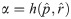
ppGpp regulation implements an on-off control strategy of resource allocation.A: Response surface of the on-off control strategy, defined by α=h(p^,r^) in Eq 19. B: Response surface of the ppGpp control strategy, as defined by Eq 20 and the simplified kinetic model defining ppGpp in terms of the total amino acid concentration and the ribosomal protein fraction (S4 Text). The shape of the response surface of the ppGpp control strategy is seen to be in very good agreement with the on-off strategy leading to near-optimal performance of the self-replicator during a nutrient upshift.